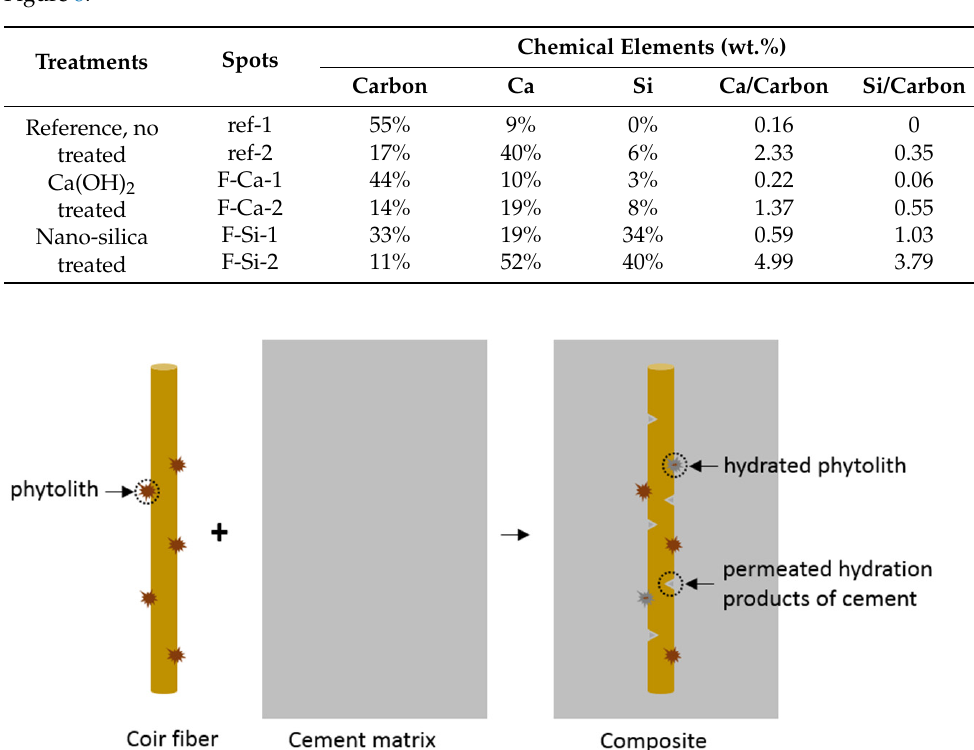
Figure 10. Drying shrinkage of LWAC with coir fibers of various contents and different treatments measured in 56 days. Figure 11 shows the autogenous shrinkage development in coir fibers reinforced con- crete within 56 days. Most of the autogenous shrinkage is developed within the first week and then its intensity appears to reduce because of subdued cement hydration. Coir fibers result in a reduction in the autogenous shrinkage, and the increasing amounts of fibers significantly decreases the autogenous shrinkage. This performance is due to the higher quantity of coir fibers contributing to sufficient internal curing water, which compensates for cement internal self-desiccation caused by chemical hydration [67]. As a result, a lower capillary pressure is induced, and thus less autogenous shrinkage is observable. Another